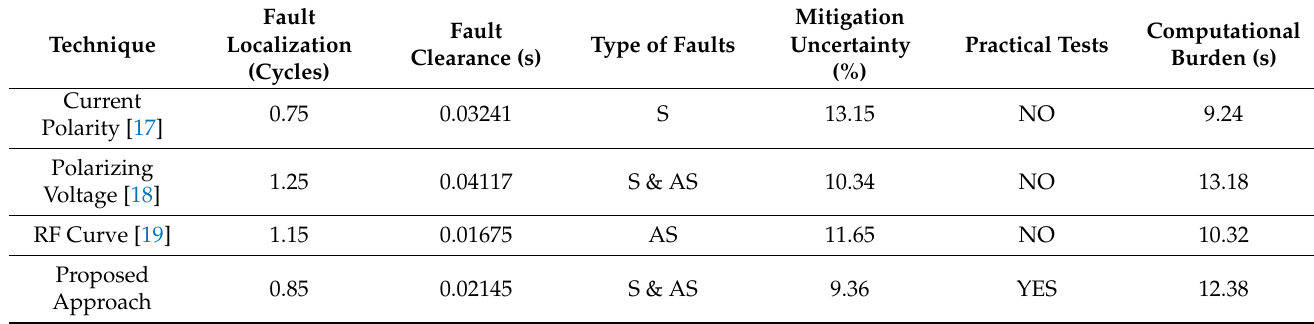
Table 2. Comparative analysis of proposed coordination scheme with other state of art techniques.